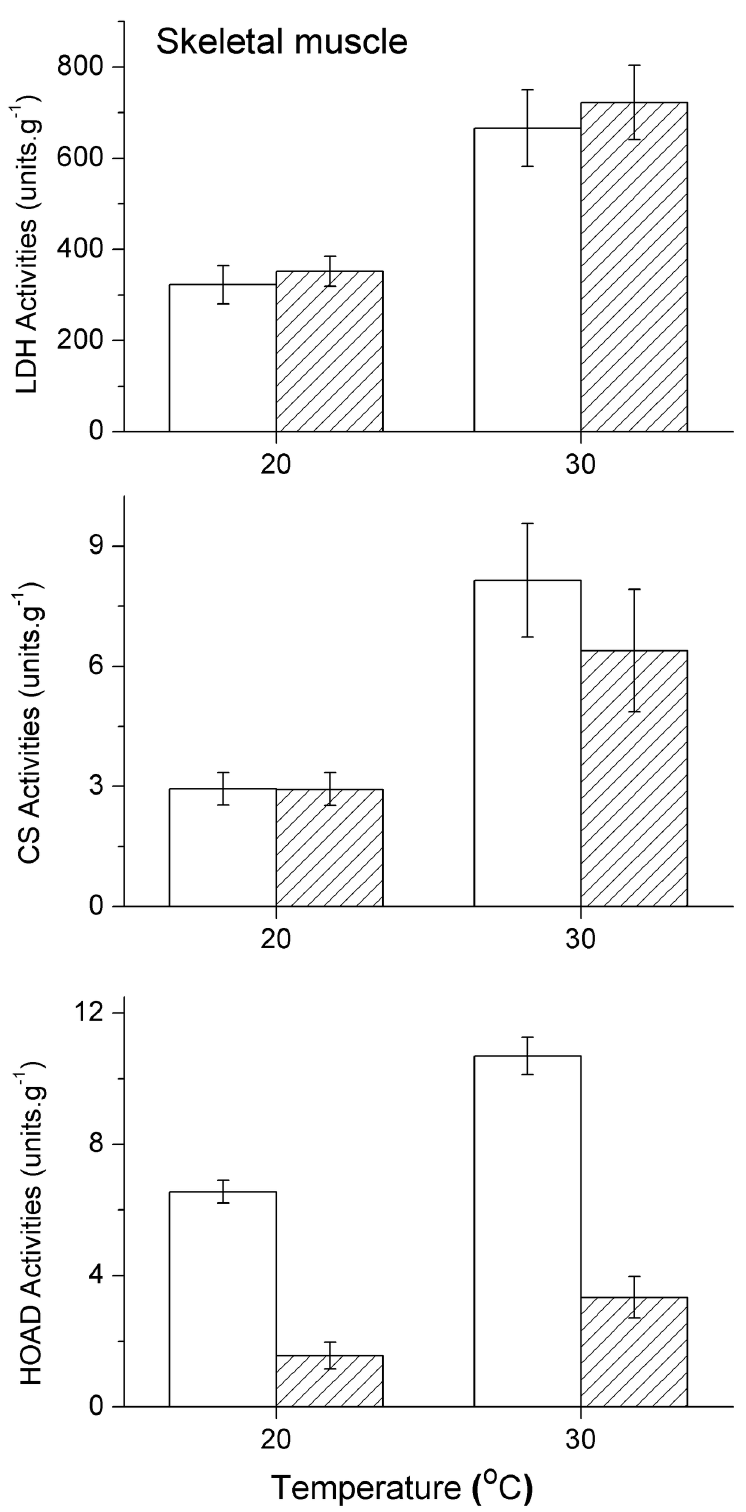
Figure 3. Activities of lactate dehydrogenase (LDH), citrate synthase (CS) and β-hydroxyacyl coenzyme A dehydrogenase (HOAD) at 20 and 30°C in the skeletal muscle of Phrynocephalus erythrurus (Open columns) and Phrynocephalus przewalskii (Twill columns). Values are means ± s.e.m. doi: 10.1371/journal.pone.0071976.g003 PLOS ONE |